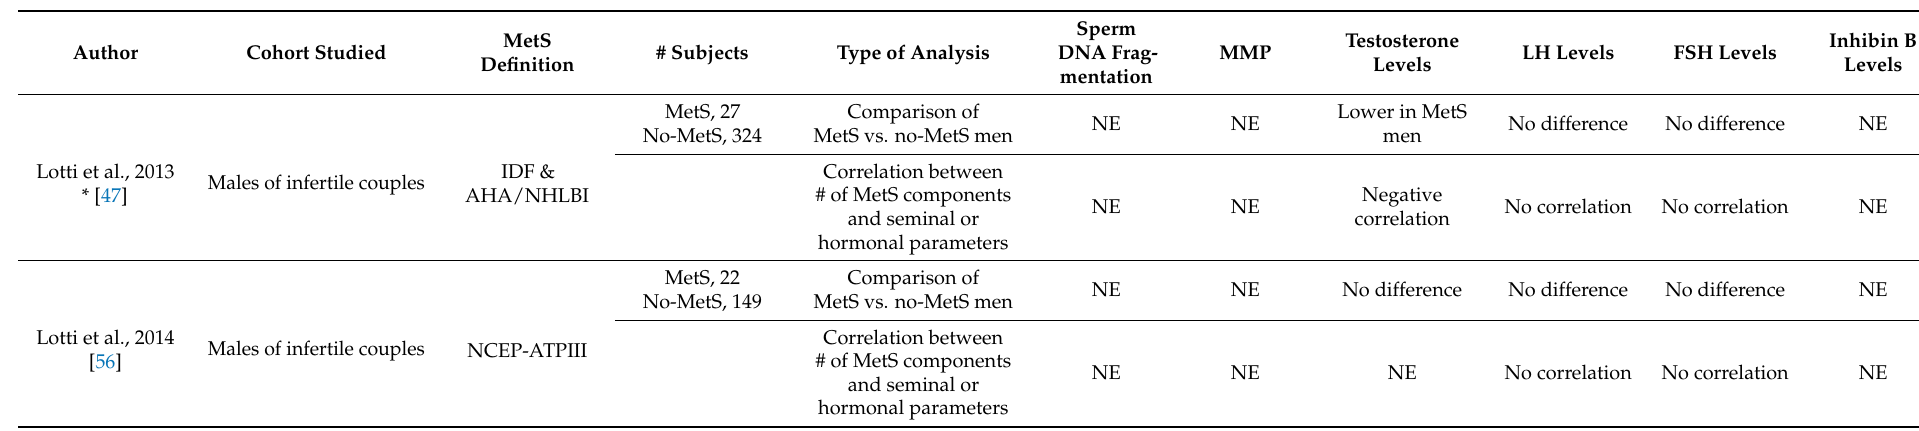
Table 4. Studies reported in Table 2 investigating the relationship between MetS, “unconventional” semen parameters and sex